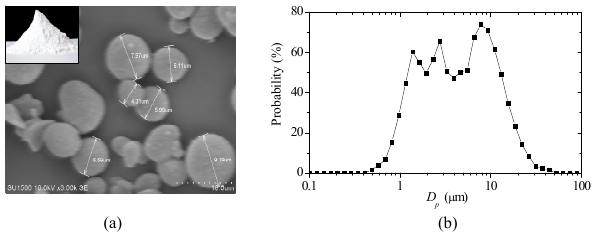
Figure 5. SiO 2 powder used as dust for the wind-tunnel experiment. (a) Powder appearance (top left corner) and microscopic picture (measured by Scanning Electron Microscope, SU1500); (b) Prob- ability distribution of particle size (measured by Particle Size Ana- lyzer, S3500).